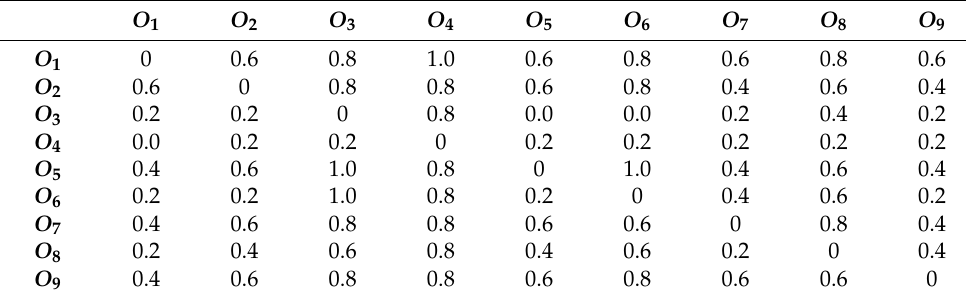
Table 20. Concordance matrix for traditional ELECTRE